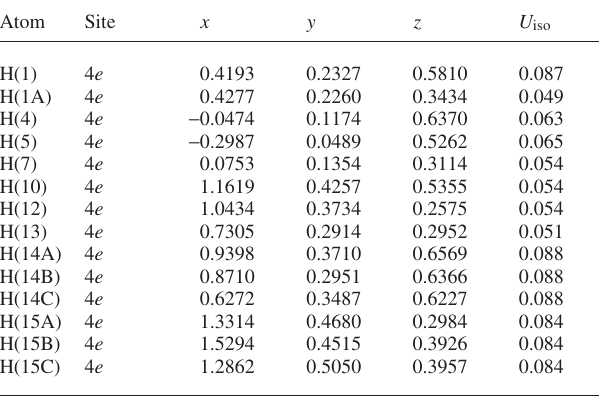
Table 2. Atomic coordinates and displacement parameters (in Å 2 )